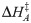
Thermodynamic parameters trends.Trends in the mean thermodynamic parameters (ΔHA‡, ΔCP and n) for strains above (solid lines) and below (dashed lines) quantile curves versus temperature. Curves are cubic-spline smoothed with df = 5 on the top row and df = 10 on the bottom row.